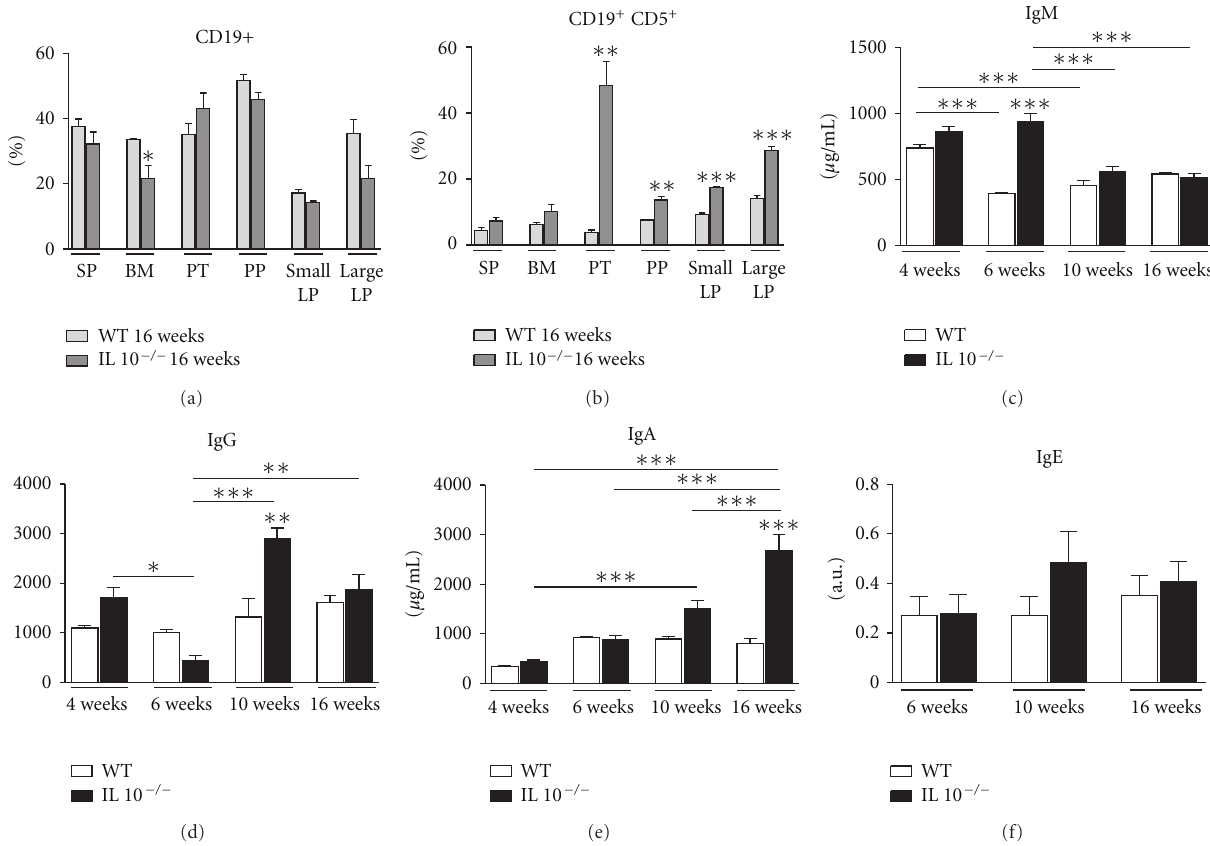
Figure 5: B cells and immunoglobulins isotype during the development of enterocolitis. Cells from spleen (SP), bone marrow (BM), Peritoneum (PT), Peyer patches (PP), or lamina propria (LP) from small or large intestine were obtained from 16-week-old IL-10 − / − mice. Frequencies of CD19 + B cells (a) or CD19 + CD5 + (b) gated on lymphocytes or CD19 + population, respectively, were assessed by flow cytometry. Bars represent the mean ± SEM of 4 mice per group. Asterisks represent di ff erence between groups ( P < 0 . 05). Sera from 4-, 6-, 10-, or 16-week-old IL-10 − / − mice were collected and total IgM (c), IgG (d), IgA (e), and IgE (f) were measured by ELISA. A.U.: arbitrary units. Bars represent the mean ± SEM of 5 mice per group. Significant di ff erences ( ∗ P < 0 . 05, ∗∗ P < 0 . 01 or ∗∗∗ P < 0 . 001) are indicated by